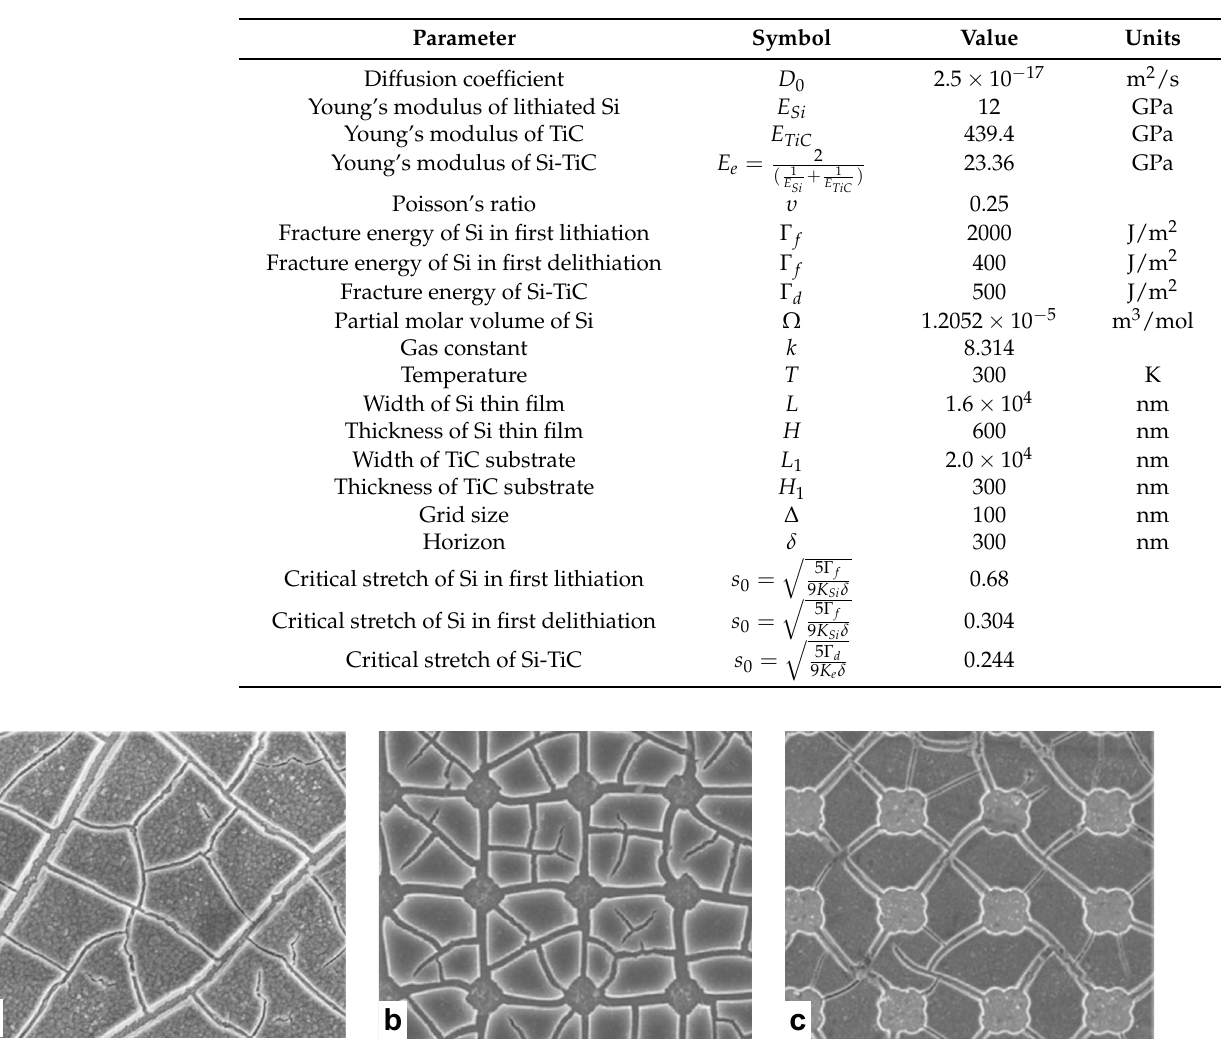
Table 1. Parameters of the materials and the numerical model.